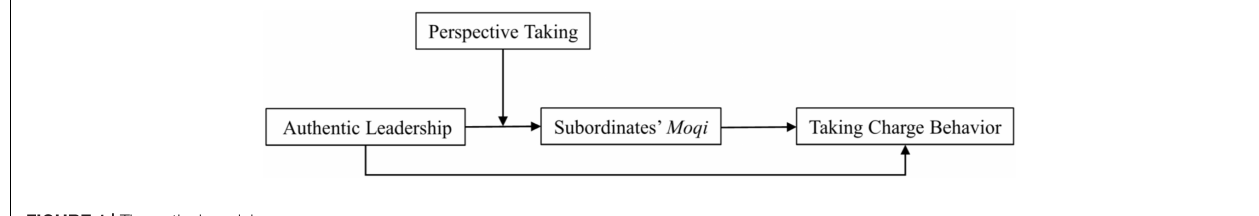
FIGURE 1 | Theoretical model. TABLE 1 | Means, standard deviations, and correlations among key variables.